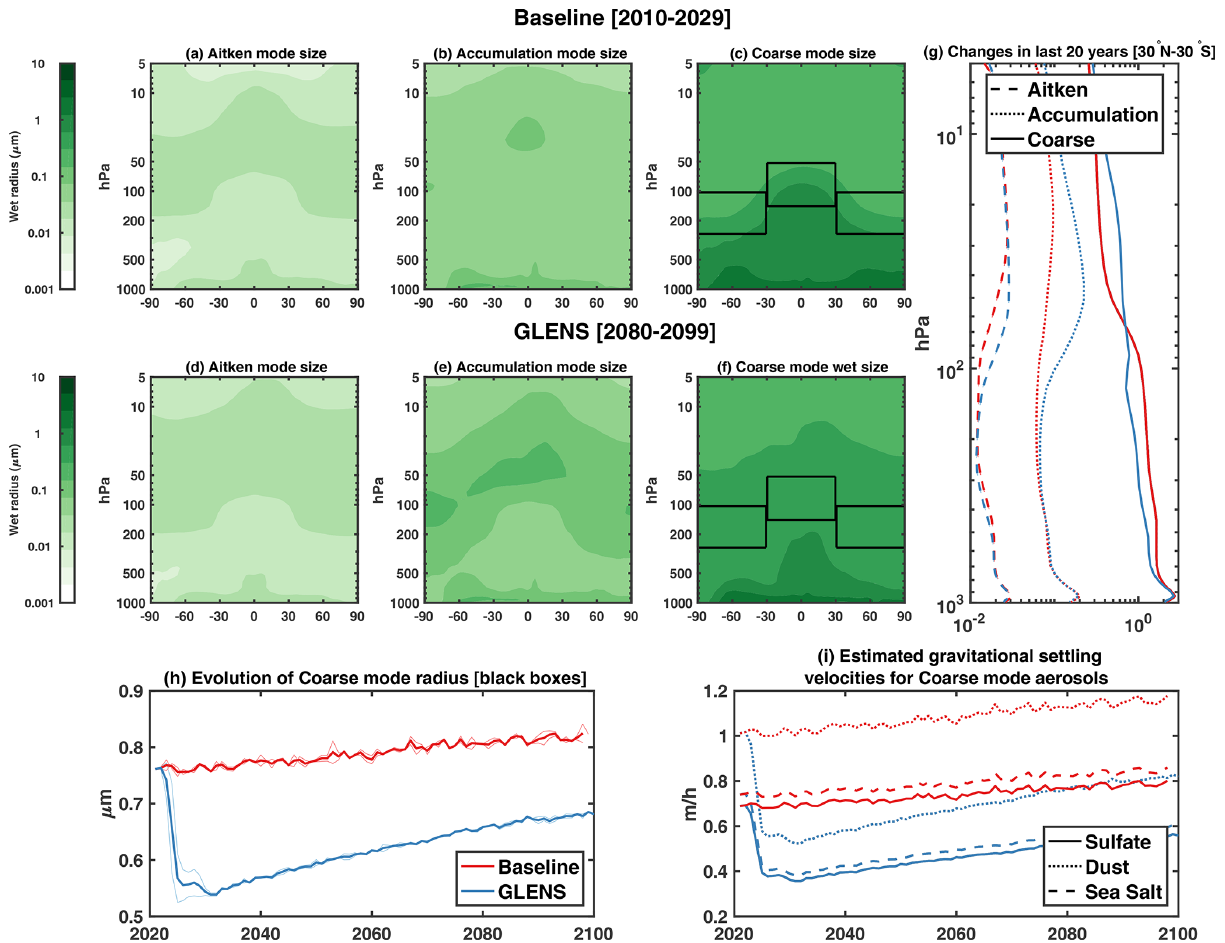
Figure 4. Wet radius (in microns) of all three modes in the Baseline case ([2010–2029], a–d ) and in GLENS ([2080–2099], e–h ). (g) Vertical distribution of aerosol size in all three modes between 30 ◦ N and 30 ◦ S. Black boxes in panels (c) – (f) indicate the average area analyzed for panel (h) , where the temporal evolution in Baseline (red) and GLENS (blue) is shown. Thinner lines show the single ensemble realizations, while the thicker lines show the ensemble mean. (i) Estimate of the changes in gravitational settling velocities following Seinfeld and Pandis